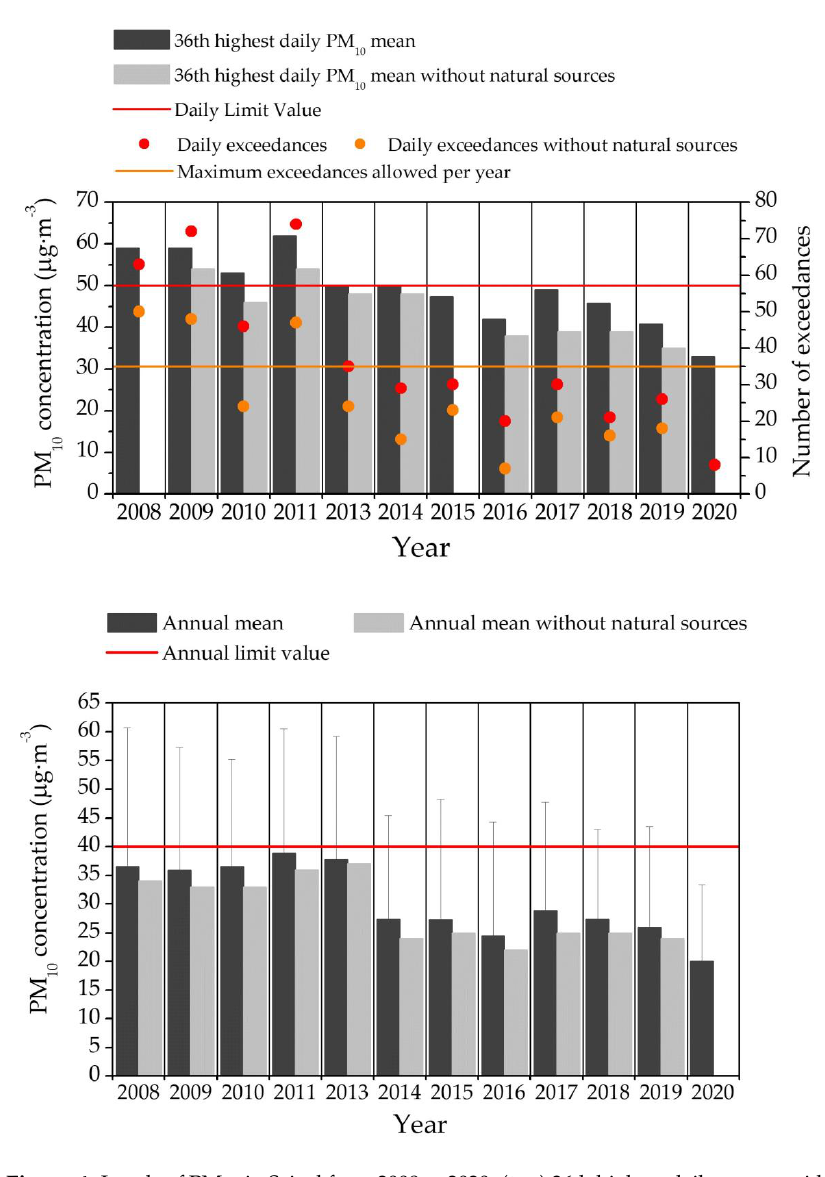
Figure 4. Levels of PM 10 in Seixal from 2008 to 2020: ( top ) 36th highest daily means with and without nat- ural sources, along with number of exceedances, ( bottom ) annual mean with and without natural